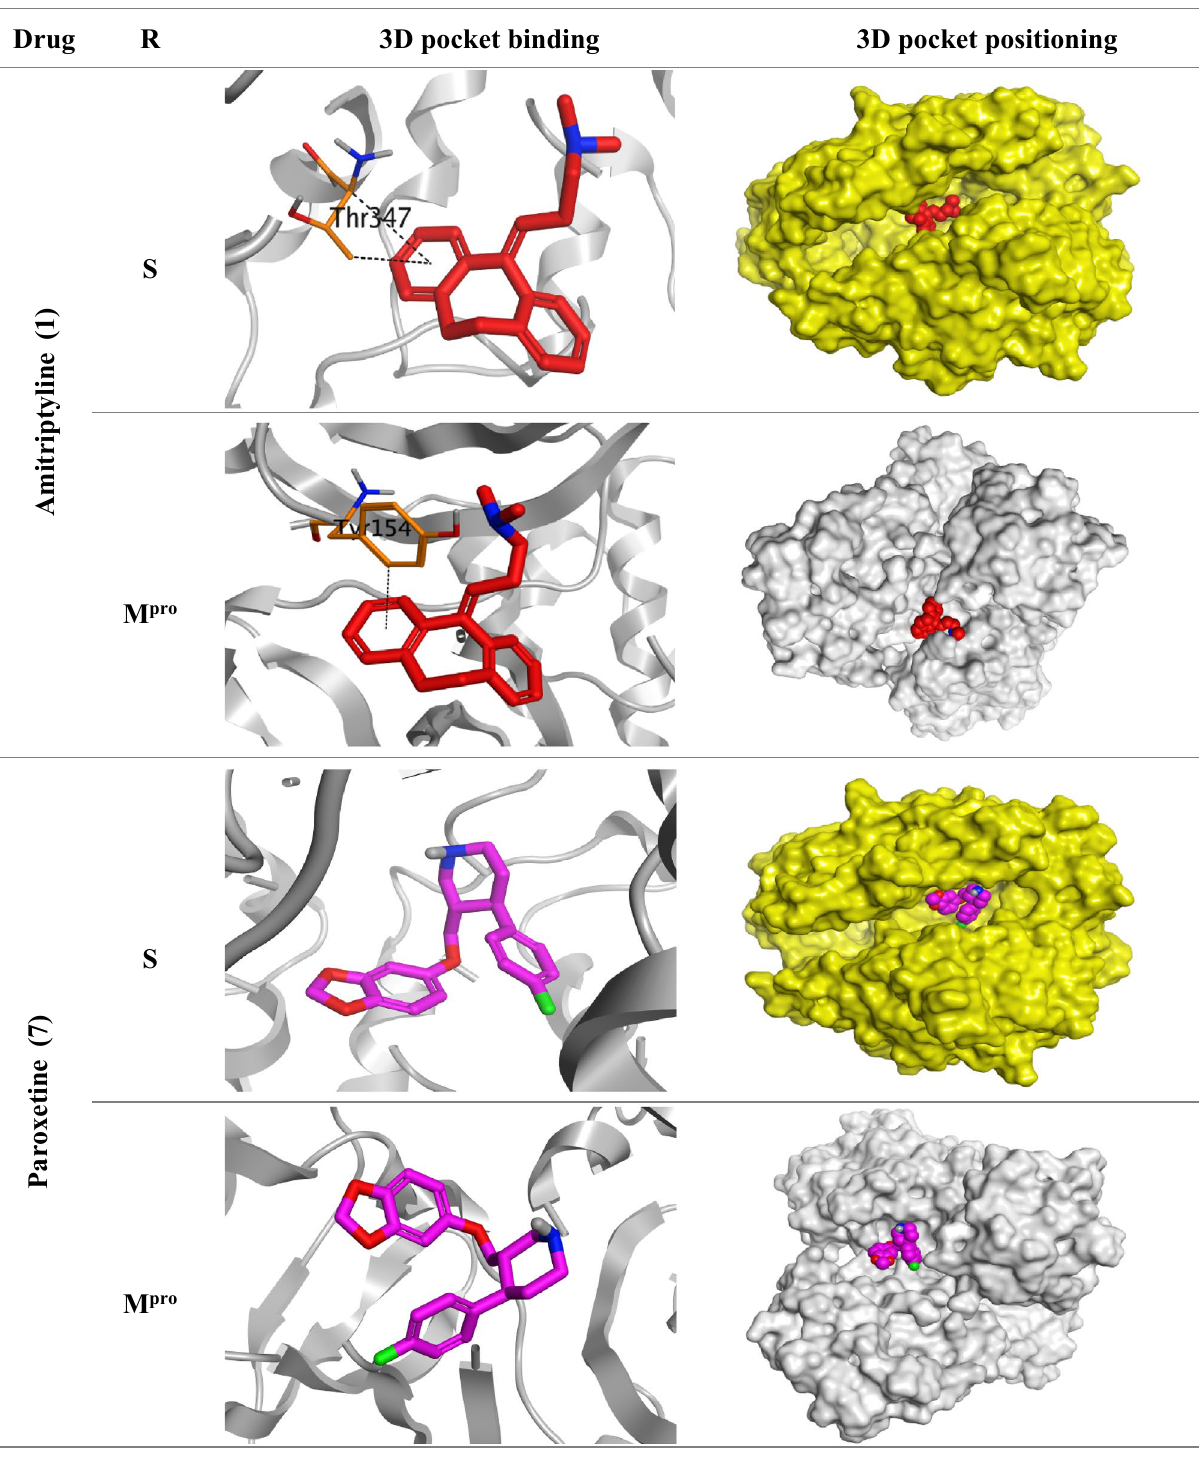
Table 2. 3D pictures of the pocket interactions and positioning for the most promising antidepressant drugs (Amitriptyline 1, and Paroxetine 7) inside the S and M pro pockets of SARS-CoV-2. Black dash represents H-pi